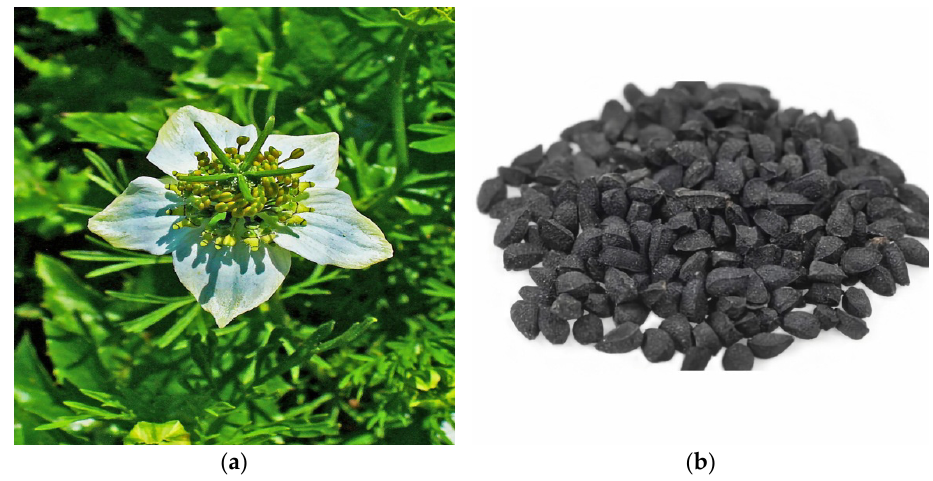
Figure 2. Nigella sativa ( a )flower ( b ) seeds [26,27].